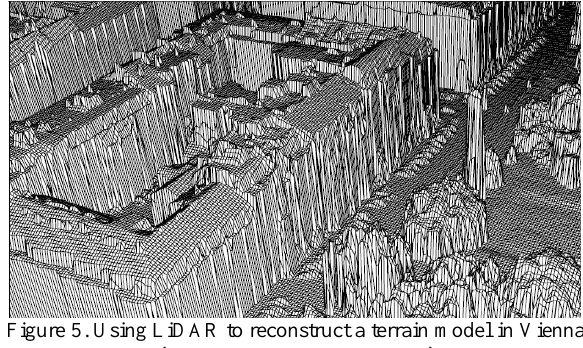
Figure 5. Using LiDAR to reconstruct a terrain model in Vienna (Rottensteiner & Briese,